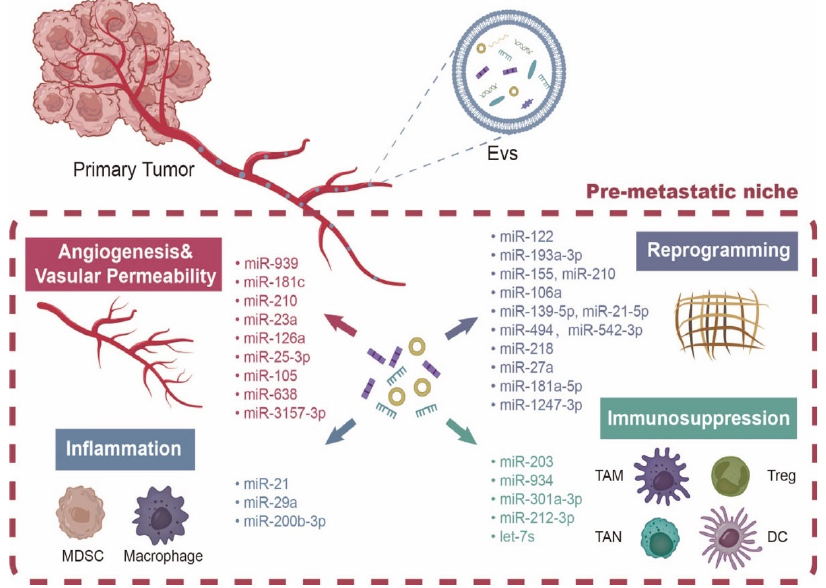
Figure 2. NcRNAs derived from EVs can establish PMN in distal part in a number of ways, including promoting inflammatory molecule increase; induced immunosuppressive or immune surveillance, leading to T cell, DC cell, and antigen ‐ presenting impairment; angiogenesis and vascular permeability increase; and by activating metabolic reprogramming and stromal cell and extracellular matrix (ECM) reprogramming.